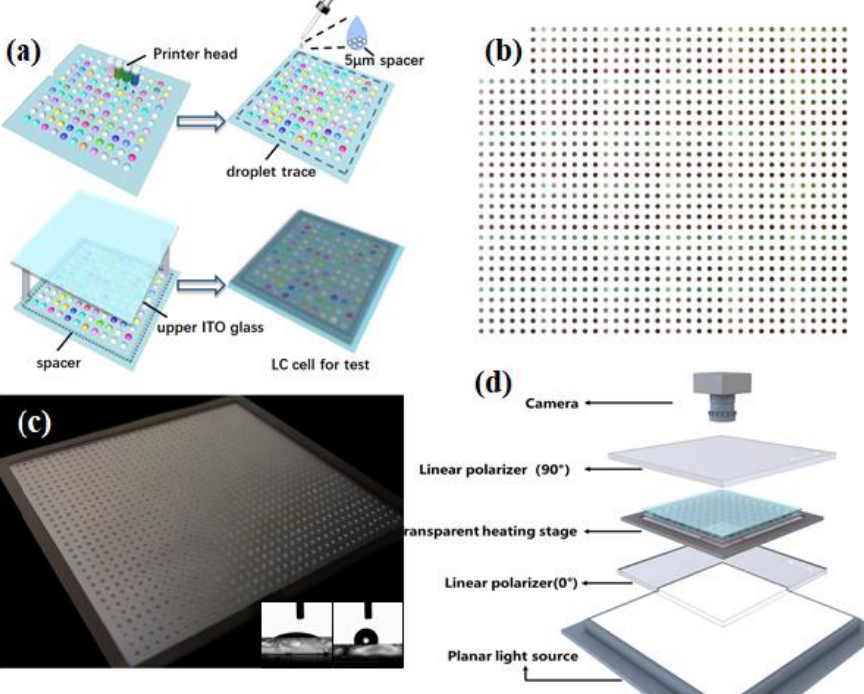
Figure 2. ( a ) Assembly process of liquid crystal high-throughput detection cell. ( b ) CMYK mixed color patterns of 1080 sample points after vector cosine similarity search. ( c ) The 1080 sample point photos were prepared by inkjet printing with high throughput. The inner are the contact angle photos of the glass substrate before and after the surface treatment. ( d ) Device structure for high-throughput detection of LC samples.